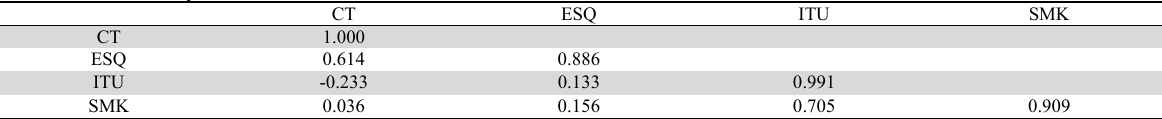
Discriminant Validity